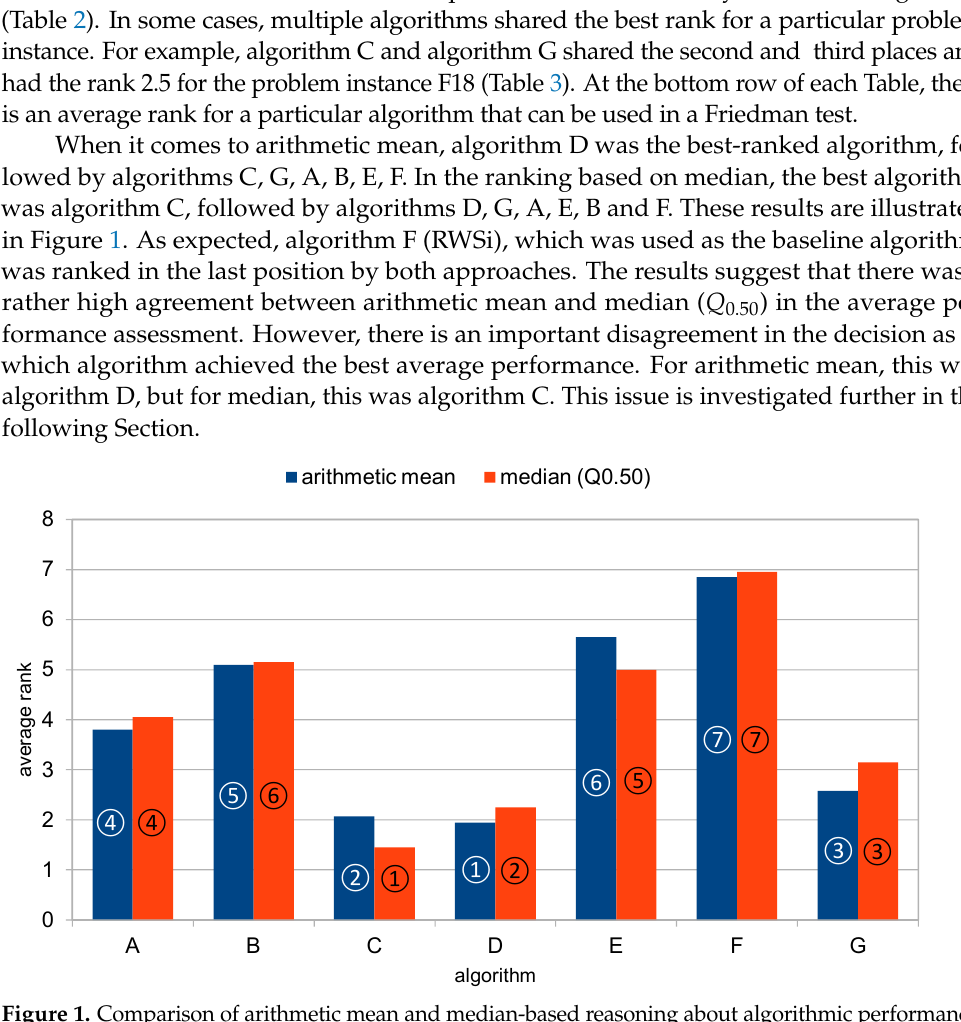
Figure 1. Comparison of arithmetic mean and median-based reasoning about algorithmic